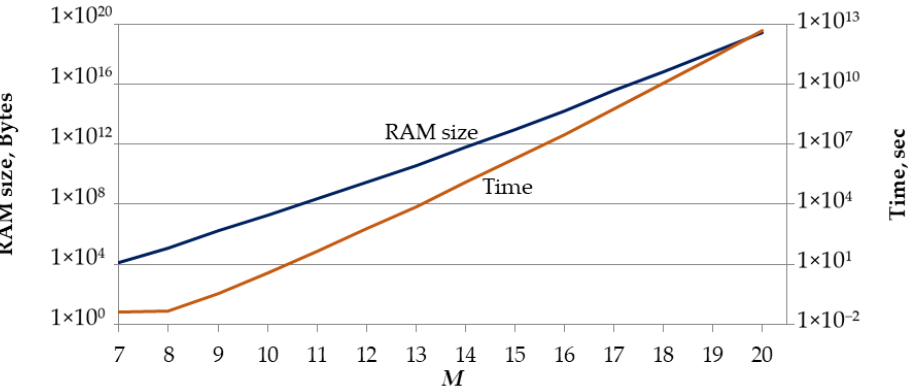
Figure 4. The required amount of memory and time to generate a complete set of M ! permutations. The average time to generate one permutation was determined experimentally by generating 1,000,000 permutations of a given length M